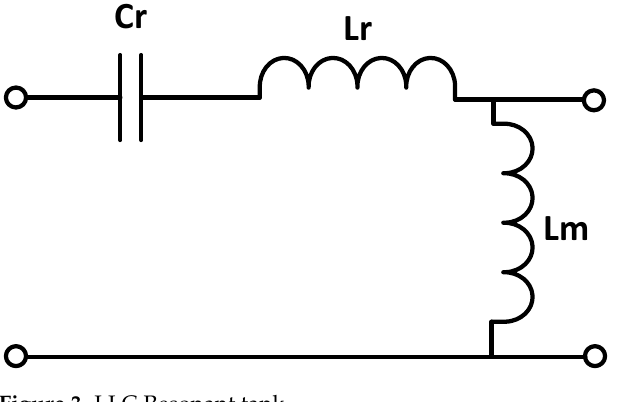
Figure 3. LLC Resonant tank.